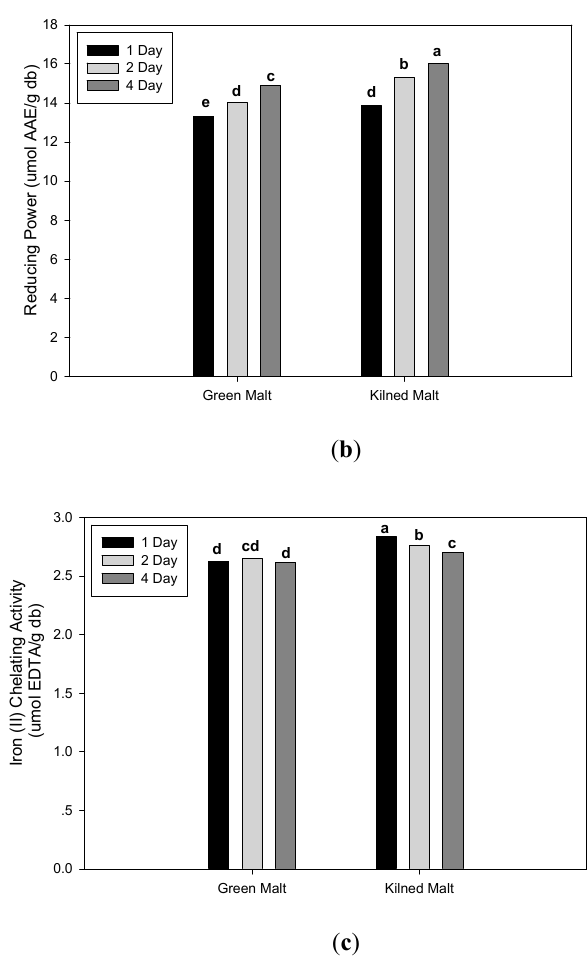
Figure 1. Interaction of malting parameters on antioxidant activities. ( a ) Interaction of malt drying type and kernel size fraction on the superoxide anion radical scavenging activity; ( b ) interaction of germination time and malt drying type on the reducing power; ( c ) interaction of germination time and malt drying type on the iron (II) chelating activity. Note: bars with the same letter are not significantly different at p ≤ 0.05.